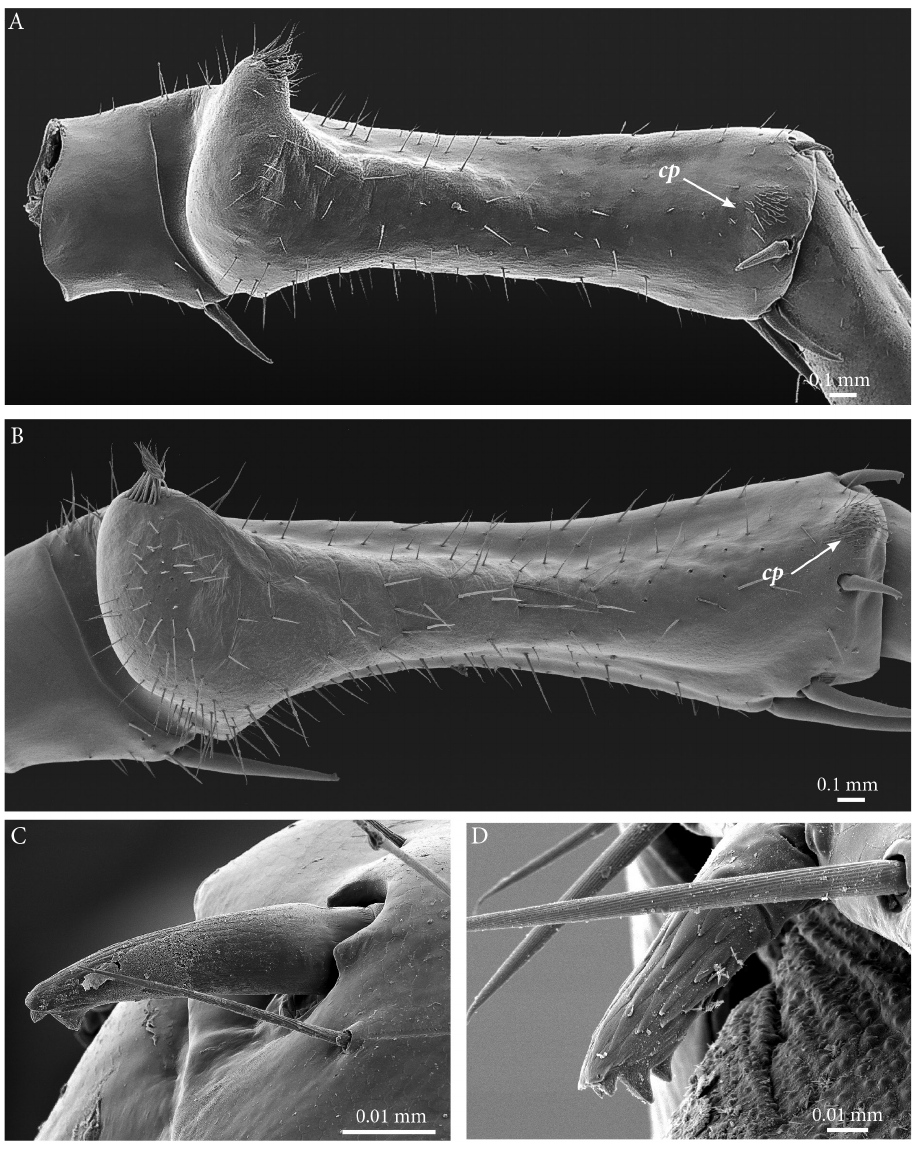
Figure 12. Prefemur of male leg 15 in mediolateral view ( A, B ) and close up of prefemoral spine ( C, D ). A E. liburnicus sp. n., male paratype B E. cavernicolus , male paratype C E. liburnicus sp. n., male paratype ZMUC 00040237 D Eupolybothrus litoralis . Abbreviation: cp. circular